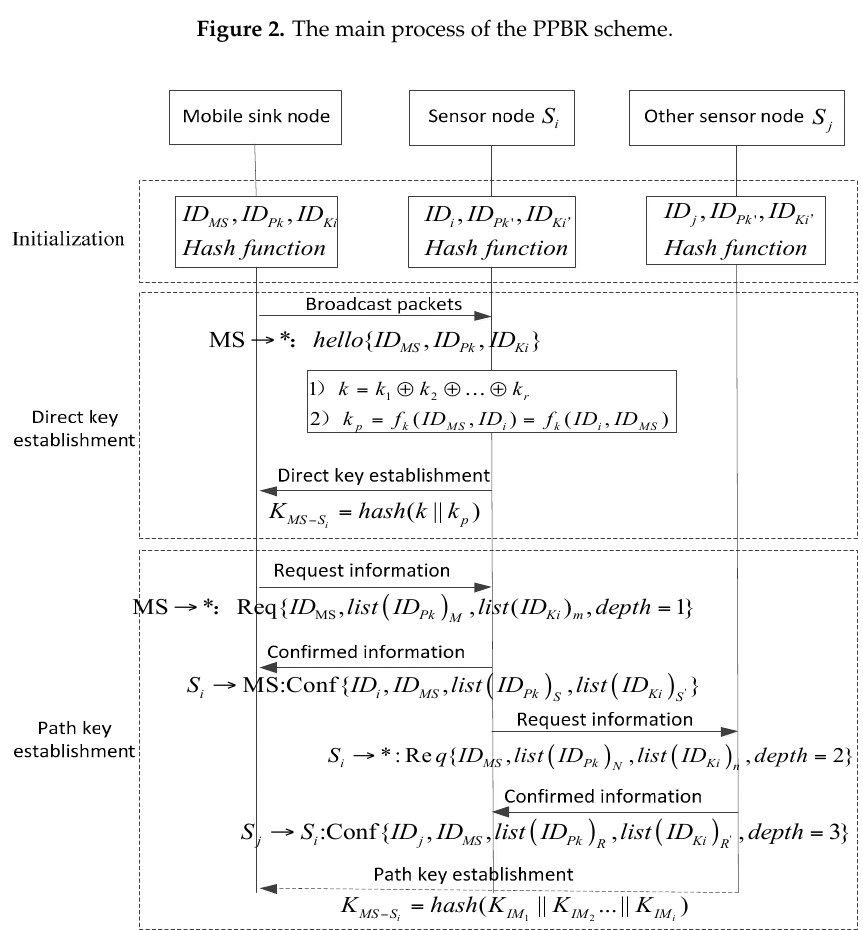
Figure 3. The steps of key establishment for the PPBR scheme.